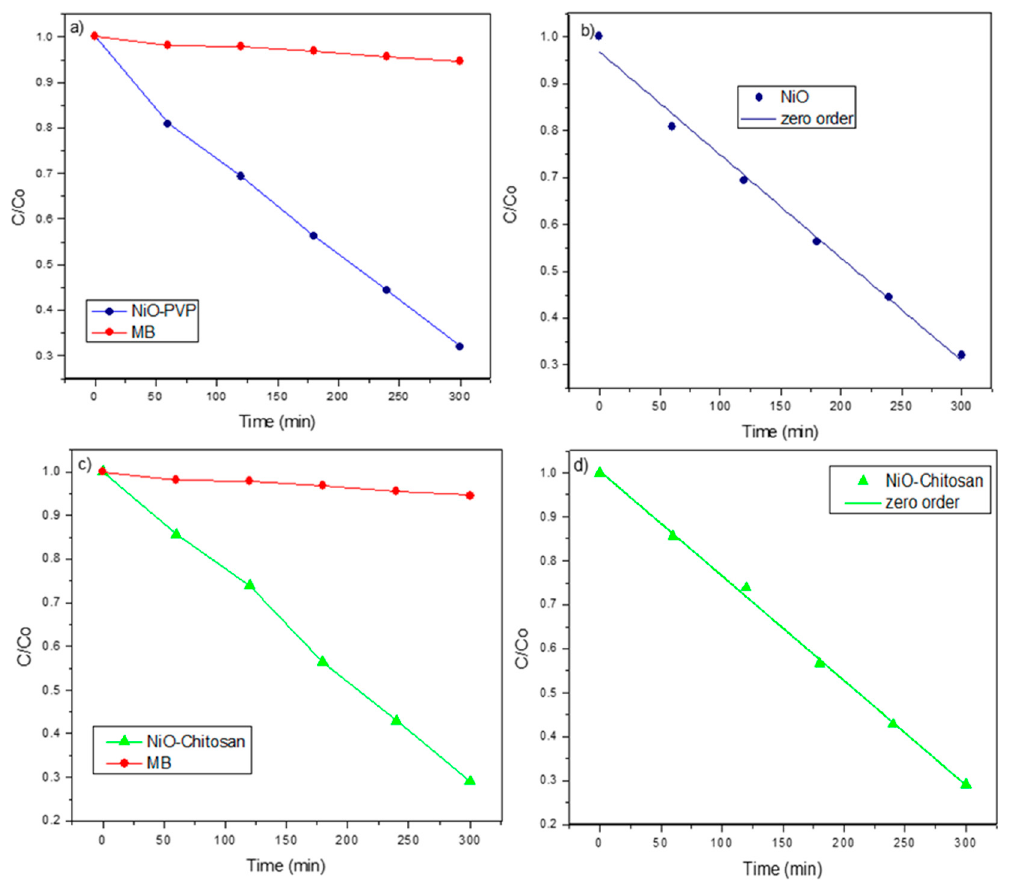
Figure 6. ( a ) Normalized concentration changing of methylene blue (MB) without the catalyst and in the presence of NiO from the PVP and ( b ) their zero order kinetic of degradation of MB, ( c ) changing of MB without the catalyst and in the presence of NiO from the chitosan and ( d ) their zero order kinetic of MB degradation.